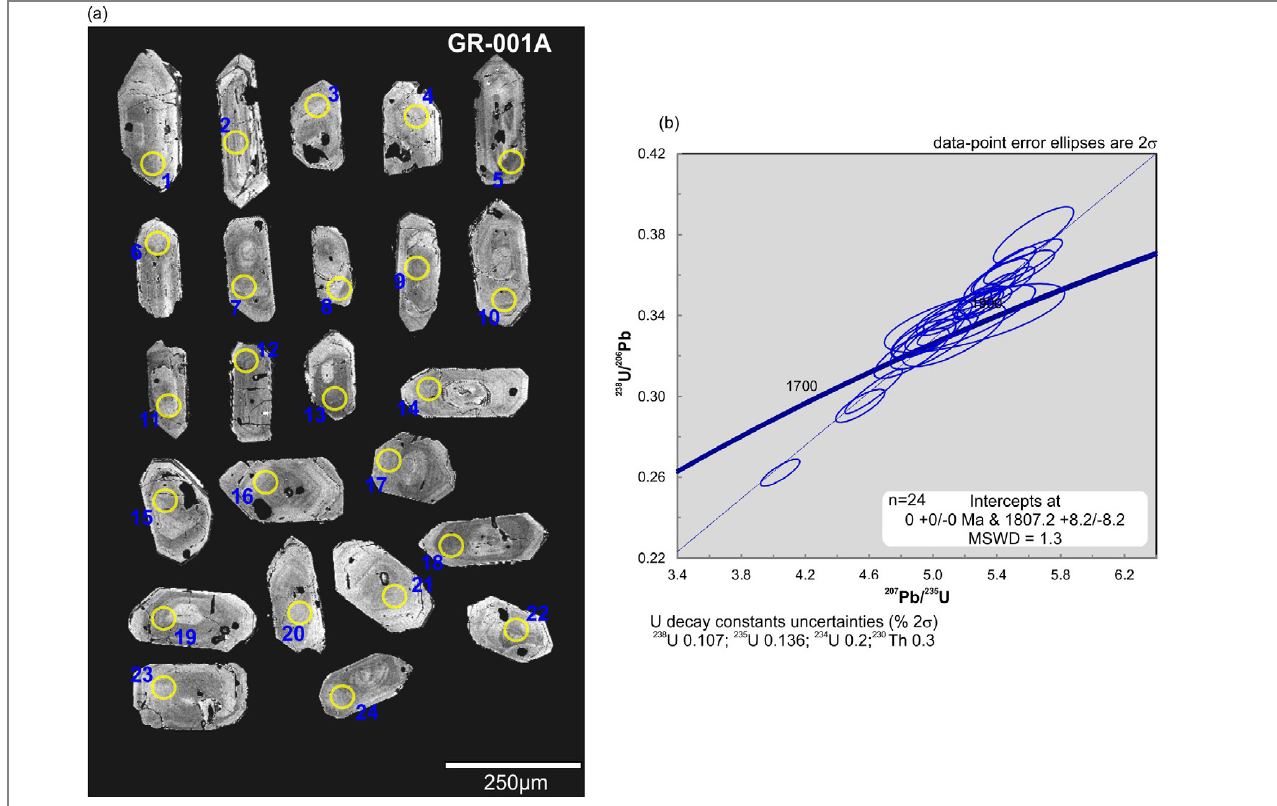
FIGURE 10 - (a) BSE image of zircons of a porphyritic granite from the Paranaíta Intrusive Suite (sample GR-001A) showing their morphological features, location and ID of pits; (b) U-Pb concordia diagram for